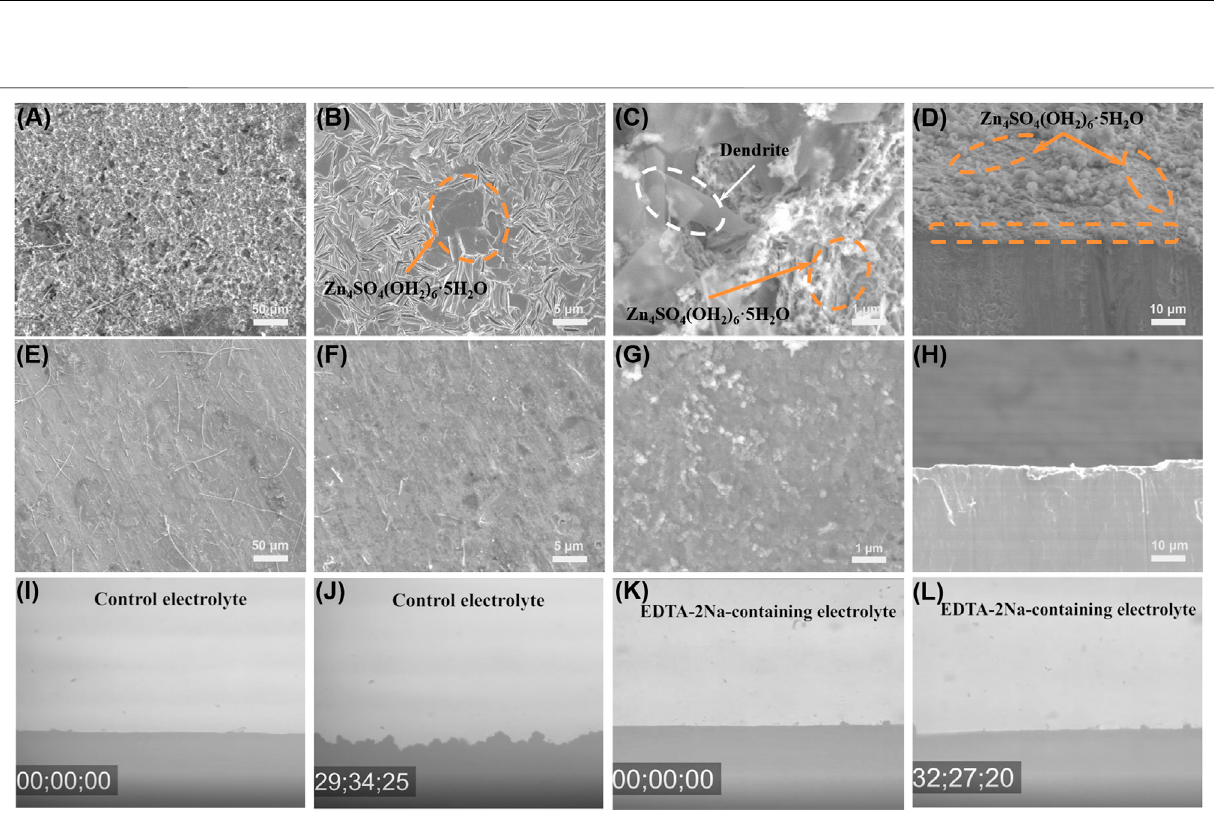
Frontiers in Chemistry |